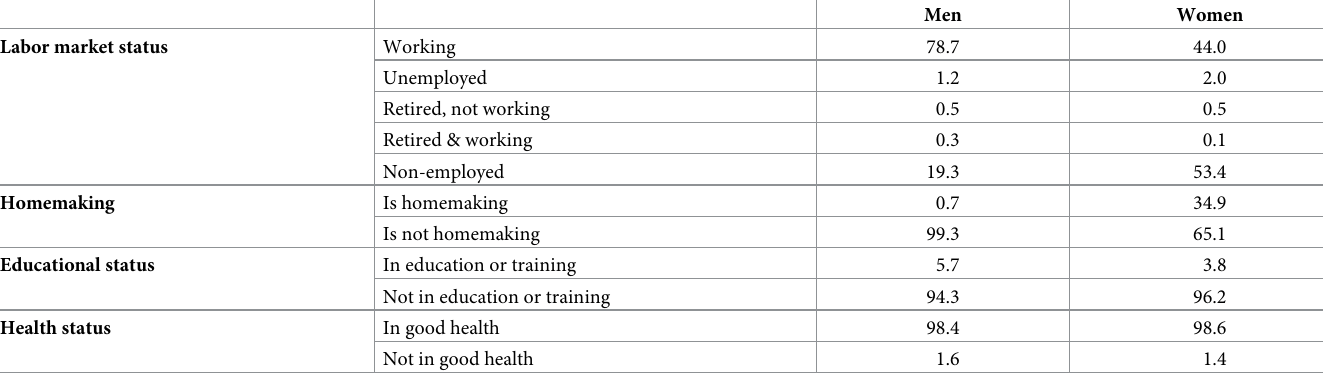
Table 3. Frequencies of activities by gender, pooled time-series (in